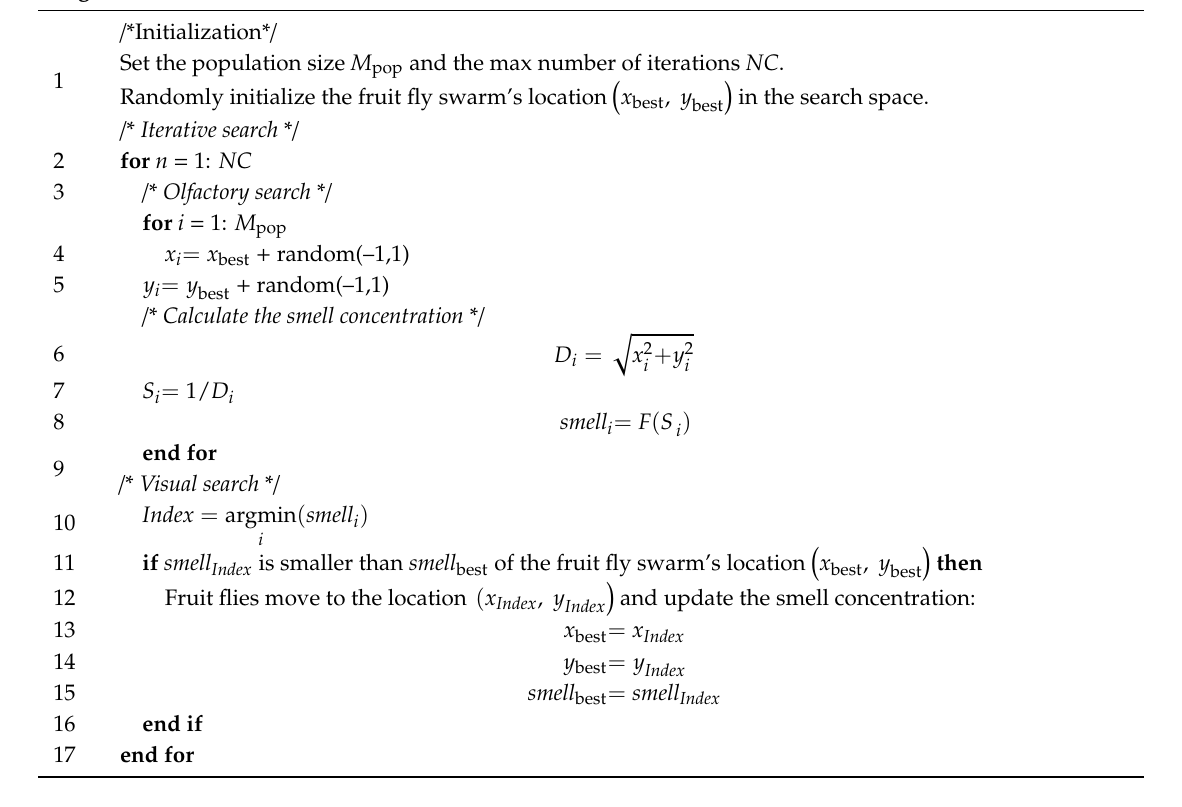
Algorithm 1: Process of the